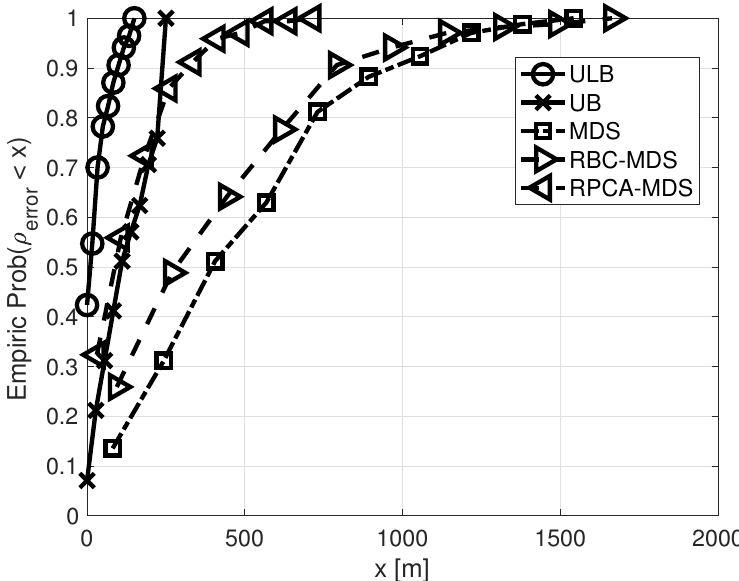
Figure 4. Empirical CDF of ρ error . Set A holds only one